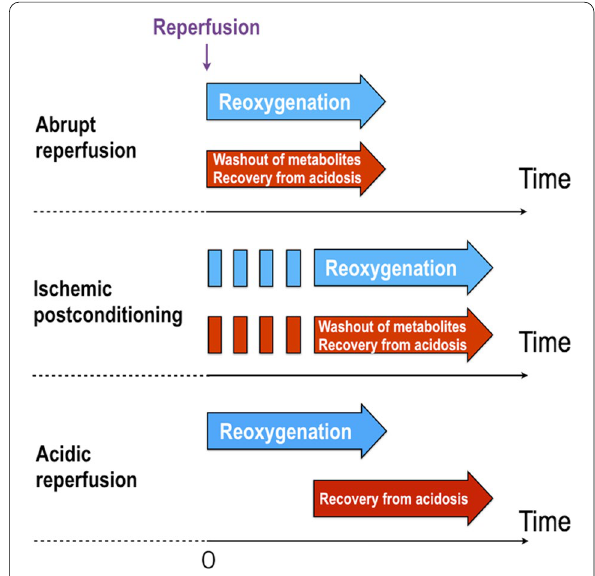
Fig. 2 Schematic representation of the difference between ischemic postconditioning and acidic reperfusion. Abrupt reperfusion simultaneously induces reoxygenation of the tissue and washout of metabolites including lactate, which is mainly responsible for intracellular acidosis produced during ischemia (upper panel). Ischemic postconditioning delays both reoxygenation and recovery from intracellular acidosis on a similar timescale (middle panel). In contrast, acidic reperfusion selectively delays the recovery from intracellular acidosis (bottom